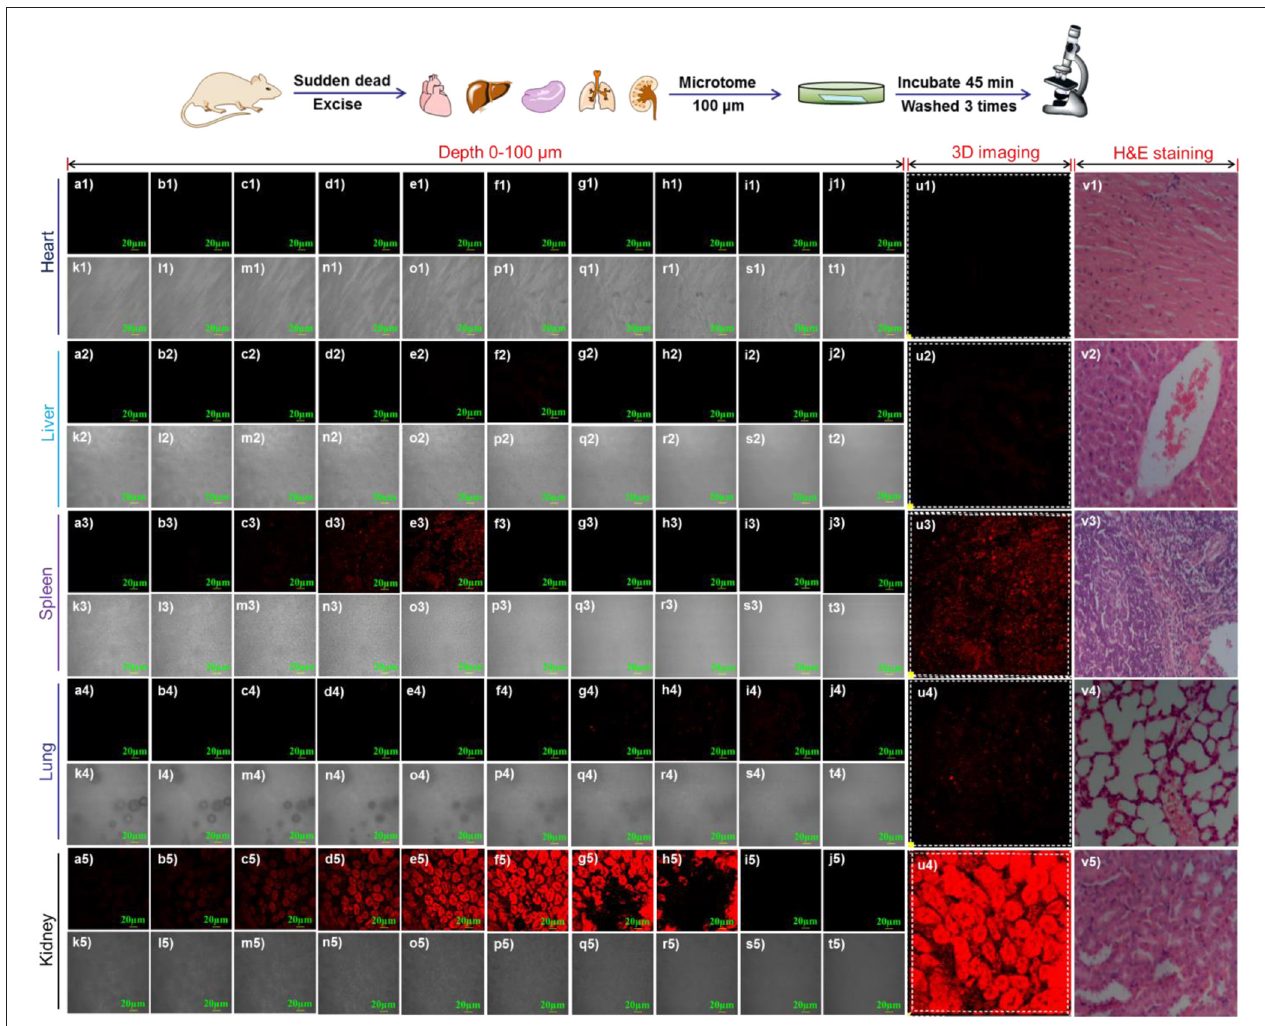
FIGURE 7 | Confocal fluorescence imaging of endogenous γ -GGT activity in various organs including heart, liver, spleen, lung and kidney. Tissue slices of 100 µ m were prepared by freezing microtome (LEICA CM1860 UV). 3D-depth images of different tissue were obtained through z -scan pattern with step size 10 µ m. (a-j) fluorescence channel; k-t bright channel; u) 3D-restruction imaging; v) HandE staining. λ ex = 488nm and λ em = 655-755nm. Scale bar = 20 µ m.